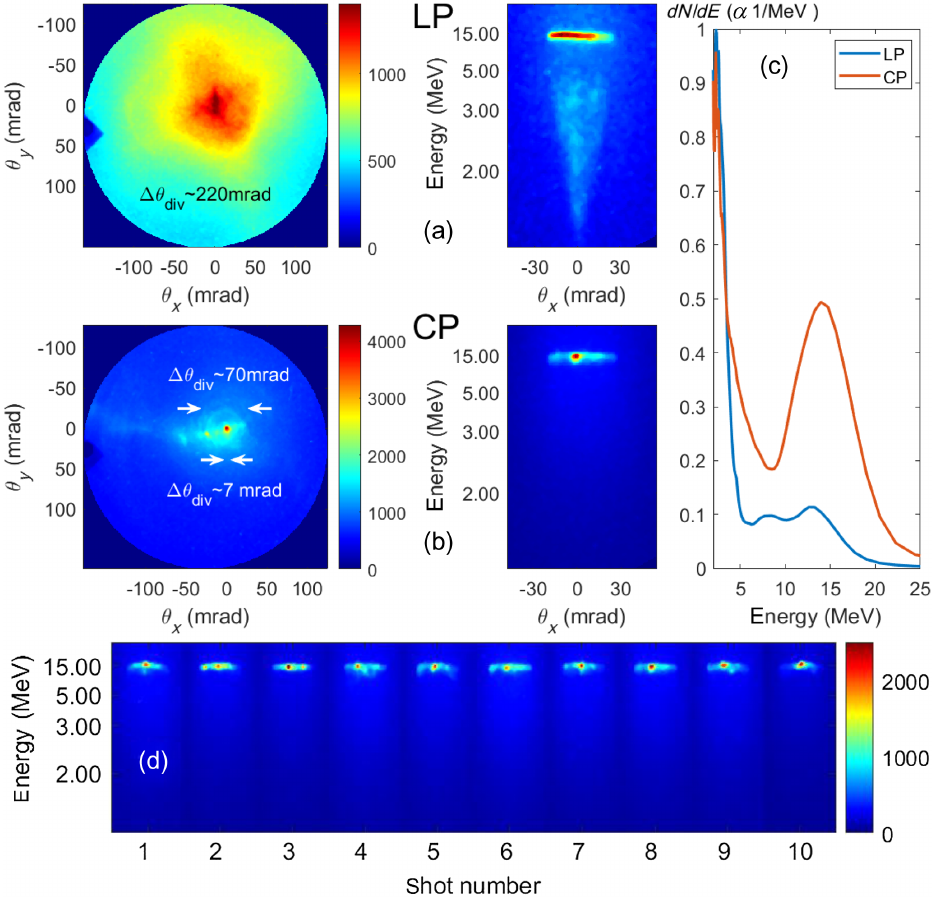
0 . 11 , ð P=P ∼ 3 . 4 , =N e; peak cr ¼ cr Þ max shown are for the central peak and the ringlike pedestal. (c) Electron div